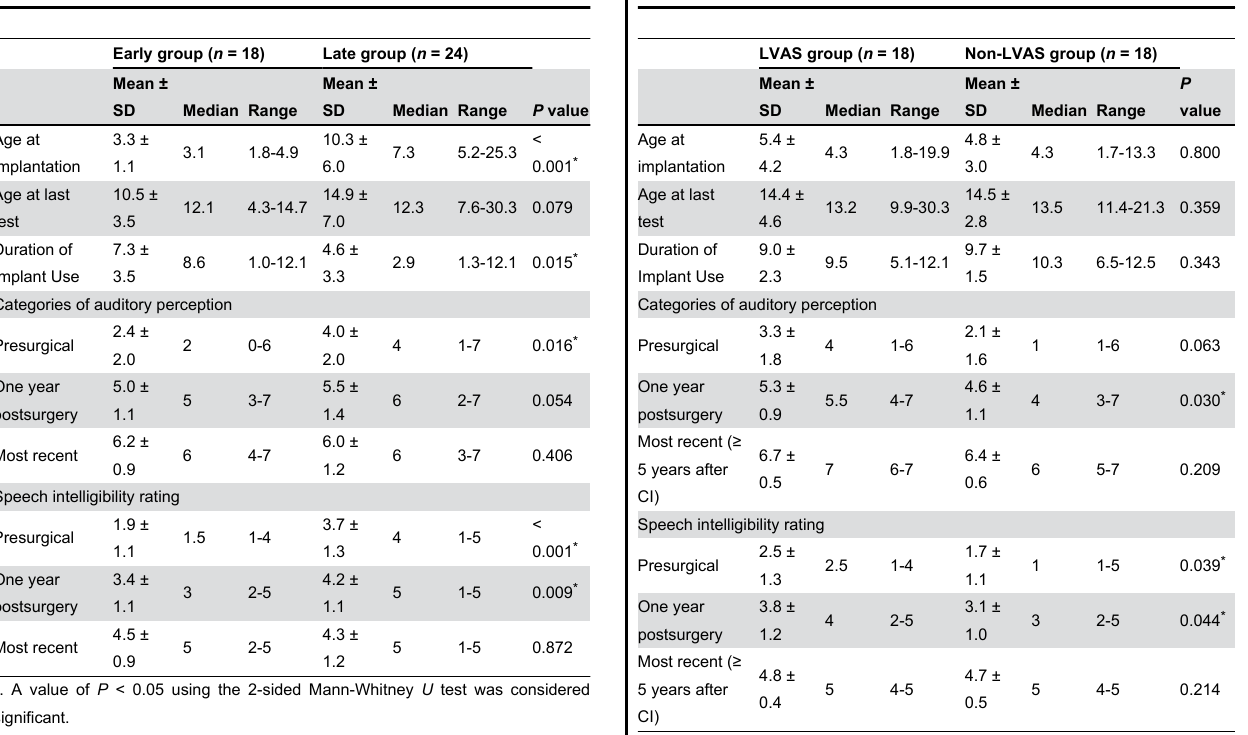
Table 2. Background information and the categories of auditory perception and speech intelligibility rating results between the early and late groups.